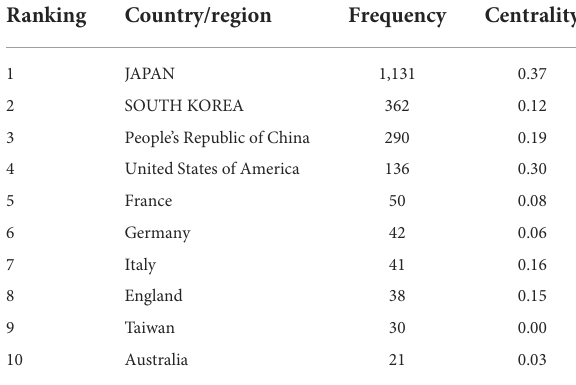
TABLE 1 Top 10 prolific countries/regions in research of ESD,